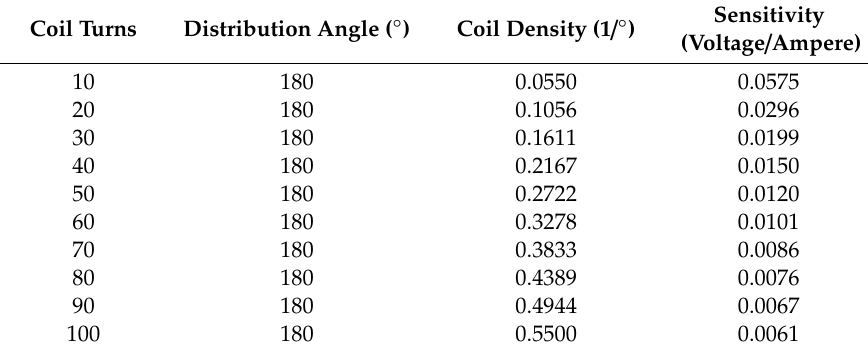
Table 1. Sensitivities corresponding to different coil turns.